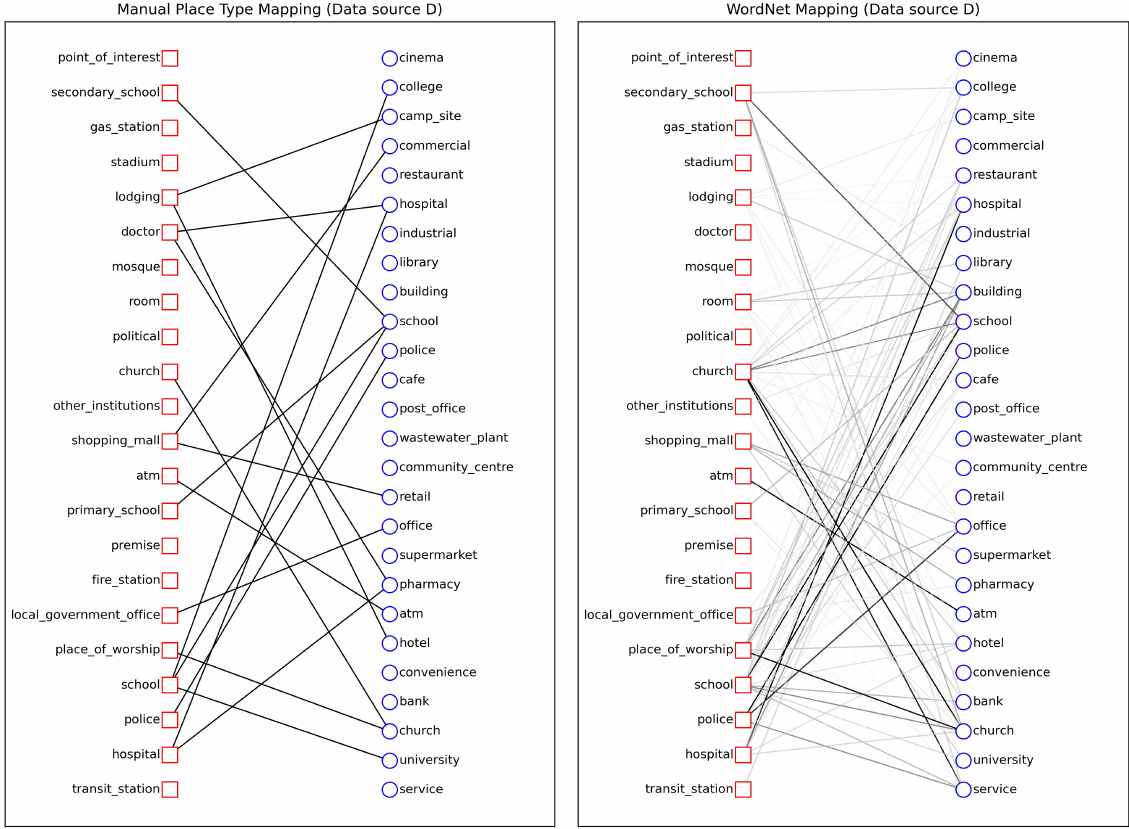
Figure 7. Example of mapping place types between D ref and data source D ( D eval ) manually ( left ) and with WordNet similarity metric ( right ). Square red nodes on left are place types from D ref , while circular blue nodes on right are place types from data source D ( D eval ). Darker lines indicate a higher WordNet similarity metric. Only pairs with a WordNet similarity score greater than 0.5 are displayed.